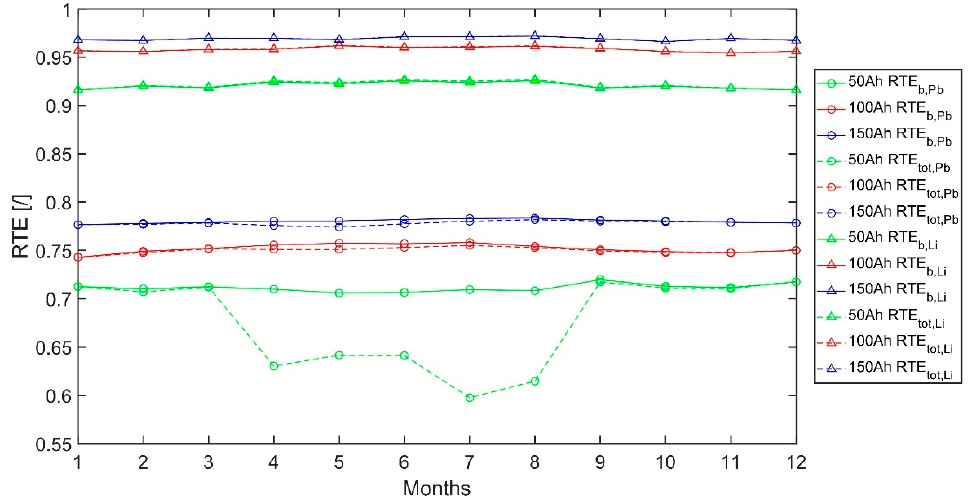
Figure 8. Comparison of RTE values among several battery solutions for both lead-acid and lithium types.